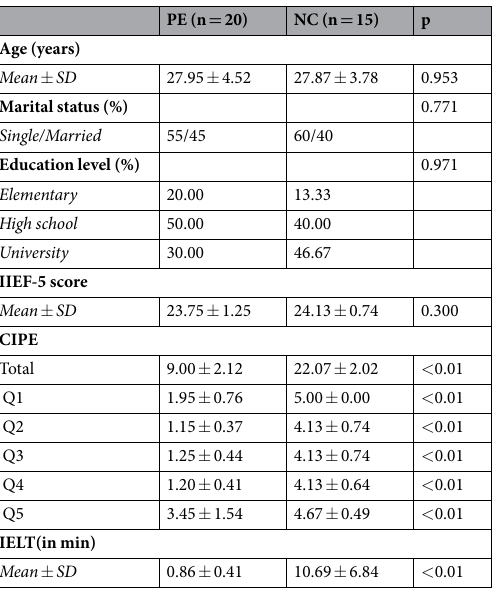
Table 1. Demographic and clinical characteristics of patients and control participants. The data from questionnaires are presented in terms of the mean scores (Mean) and standard deviation (SD) in the premature ejaculation (PE) and healthy control (NC) groups. IIEF-5 = International Index of Erectile Function-5; CIPE = Chinese Index of Premature Ejaculation; IELT (Q1), sexual satisfaction (Q2), partner’s sexual satisfaction (Q3), frequency of maintaining erection to complete sexual intercourse (Q4), frequency of feeling anxious, depressed or stressed about sexual activity (Q5); IELT = intravaginal ejaculatory latency